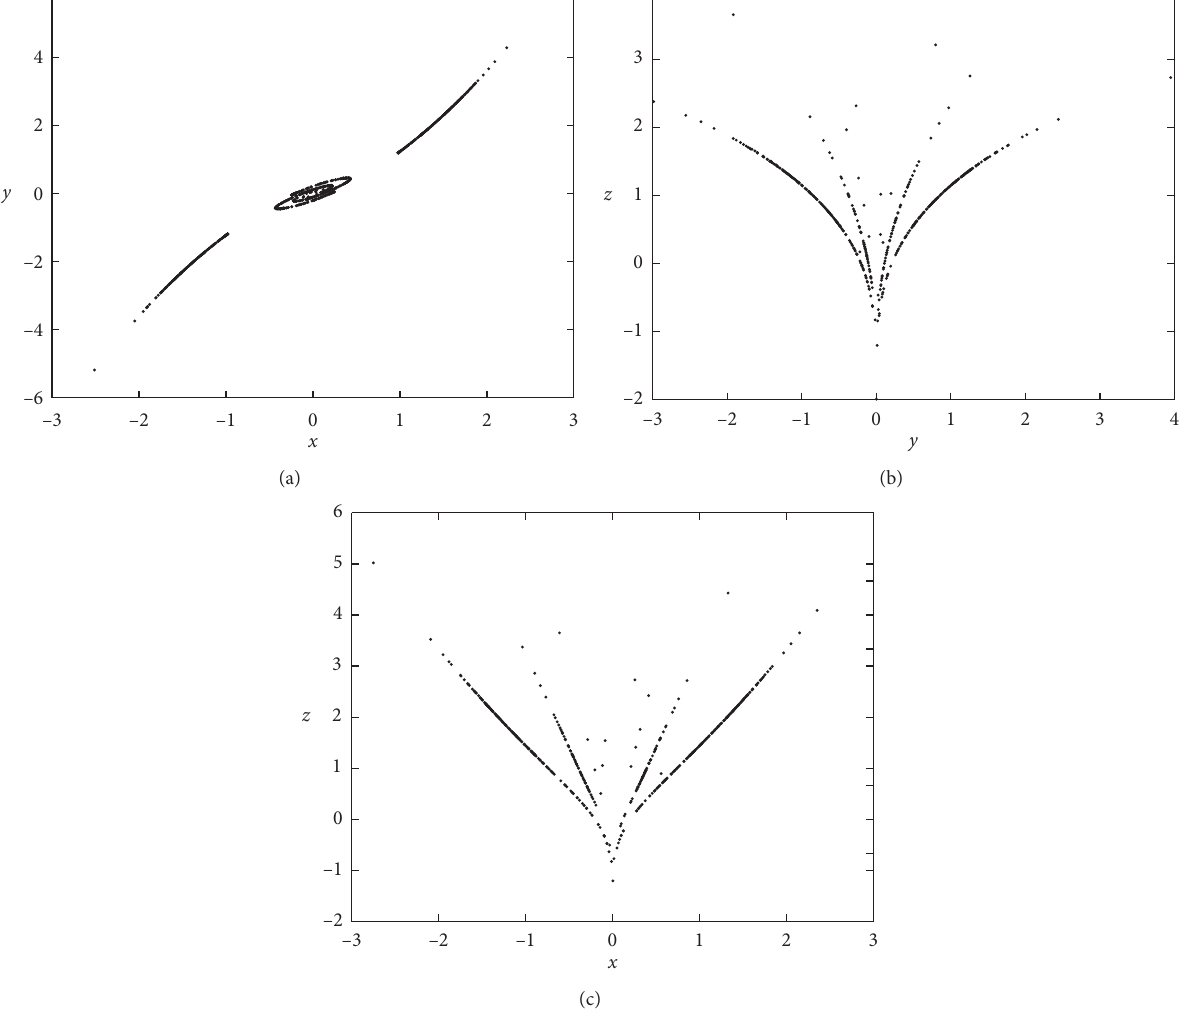
Figure 6: Poincar´e maps for (a) z � 0, (b) x � 0, and (c) y � 0.